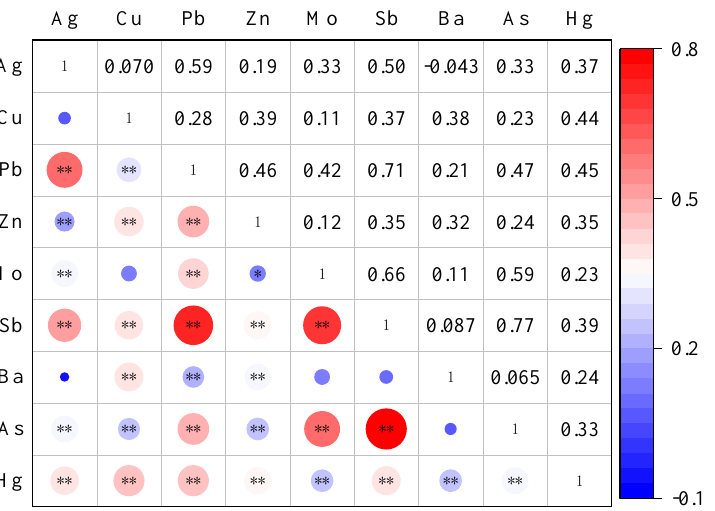
注 :* p ＜ 0.05 ** p ＜ 0.01 Figure 5. Correlation coefficient of potential toxic elements in soil. Note: * means p < 0.05, ** means p < 0.01